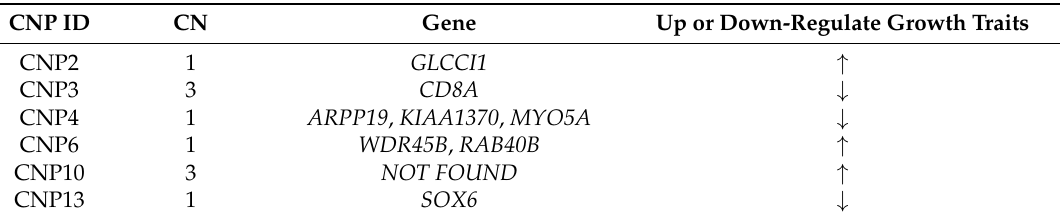
Table 4. The functions of the candidate CNPs.